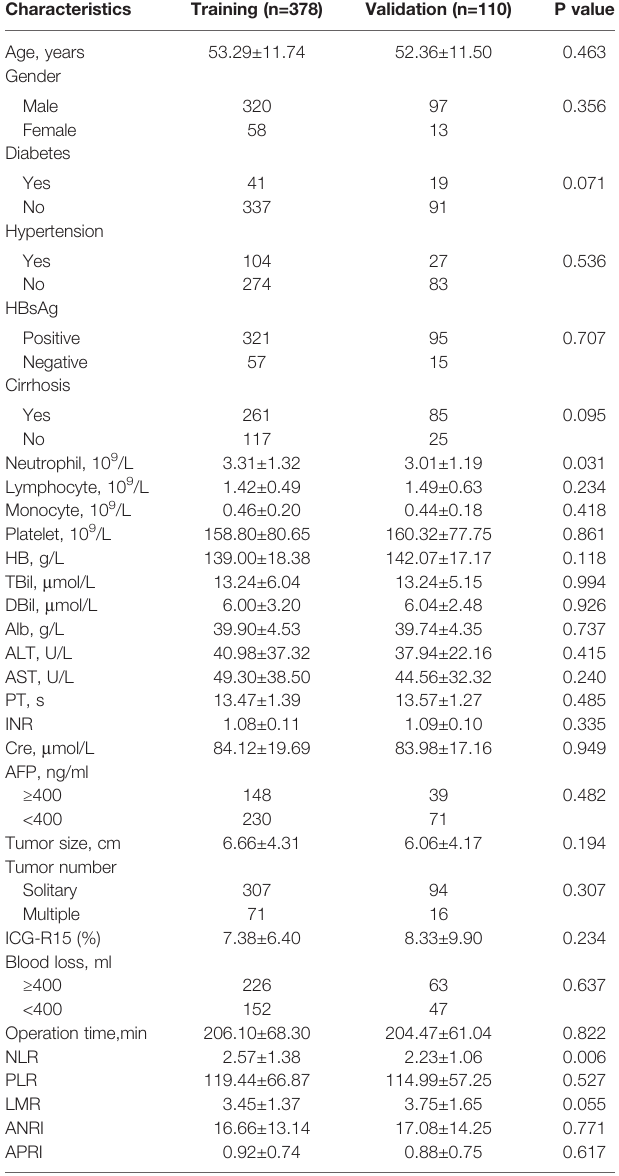
TABLE 1 | Characteristics of patients in training cohort and validation